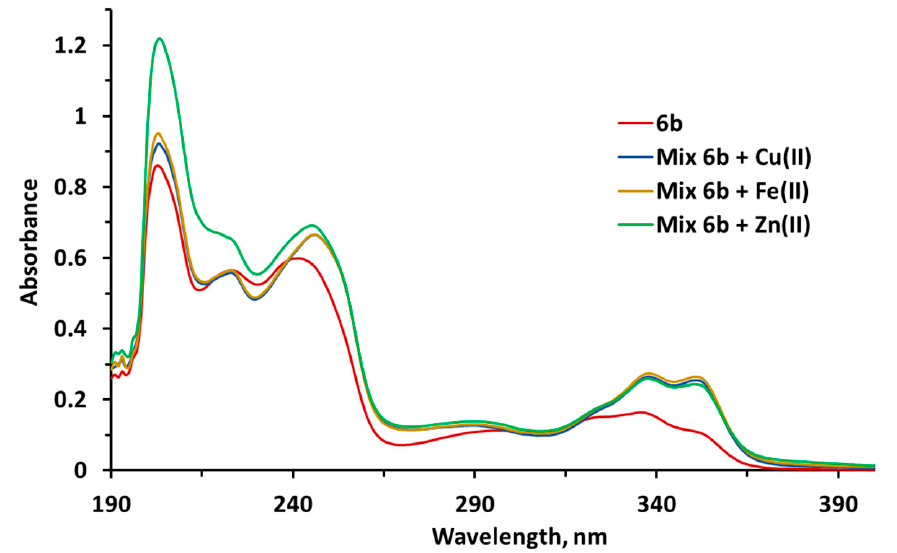
Figure 7. UV spectra of compound 6b and mixtures of 6b with Cu 2+ , Fe 2+ , and Zn 2+ ions.